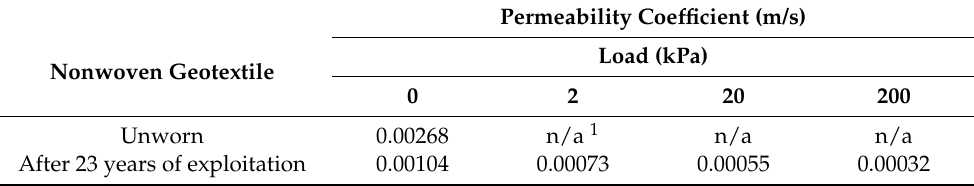
Table 9. Coefficients water permeability for nonwoven geotextiles exploited at the Białobrzegi earthfill dam (adapted from [118]).